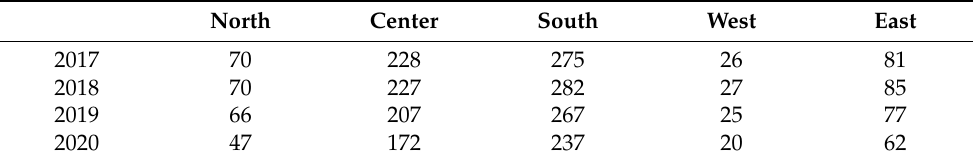
Table 3. Daily average of pixels for each year and